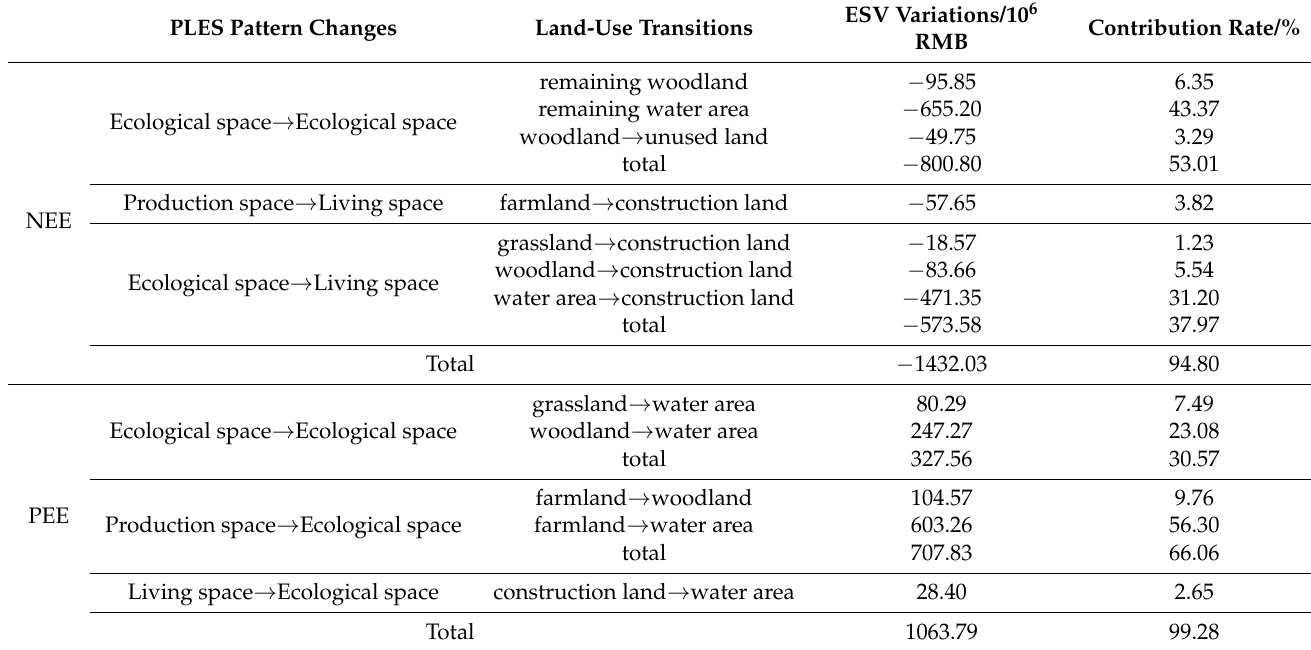
Table 9. PLES pattern changes affecting ESV in the ERAs during 2005–2018. A contribution rate <1 was not under consideration. PLES Pattern Changes